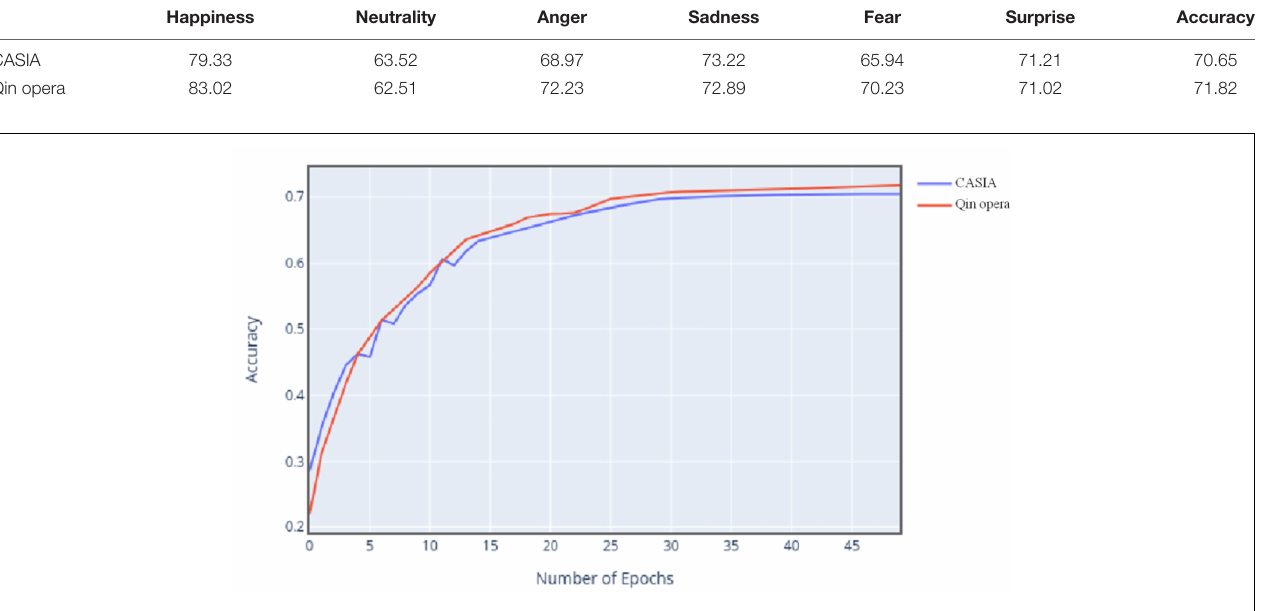
TABLE 4 | Comparison of classification accuracy of two kinds of data.